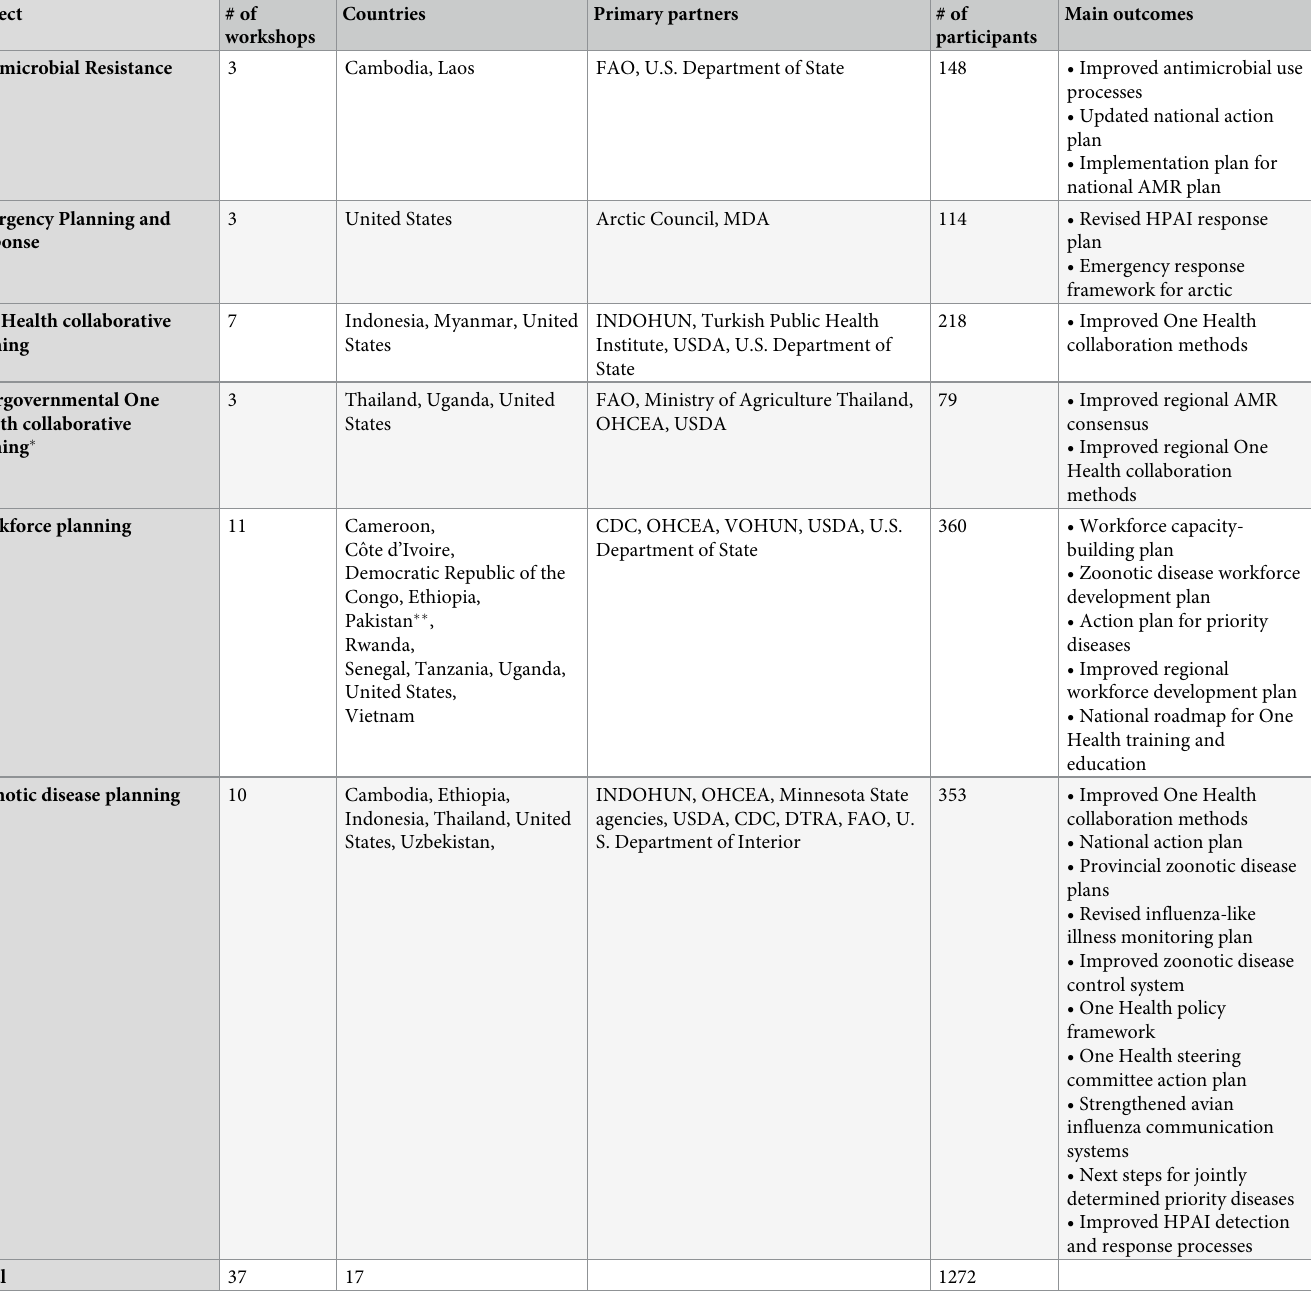
Table 5. OH-SMART Workshops from Aug. 2013 –Aug. 2018. Summary of workshops facilitated by the University of Minnesota team between Aug. 2013 –Aug. 2018, organized by